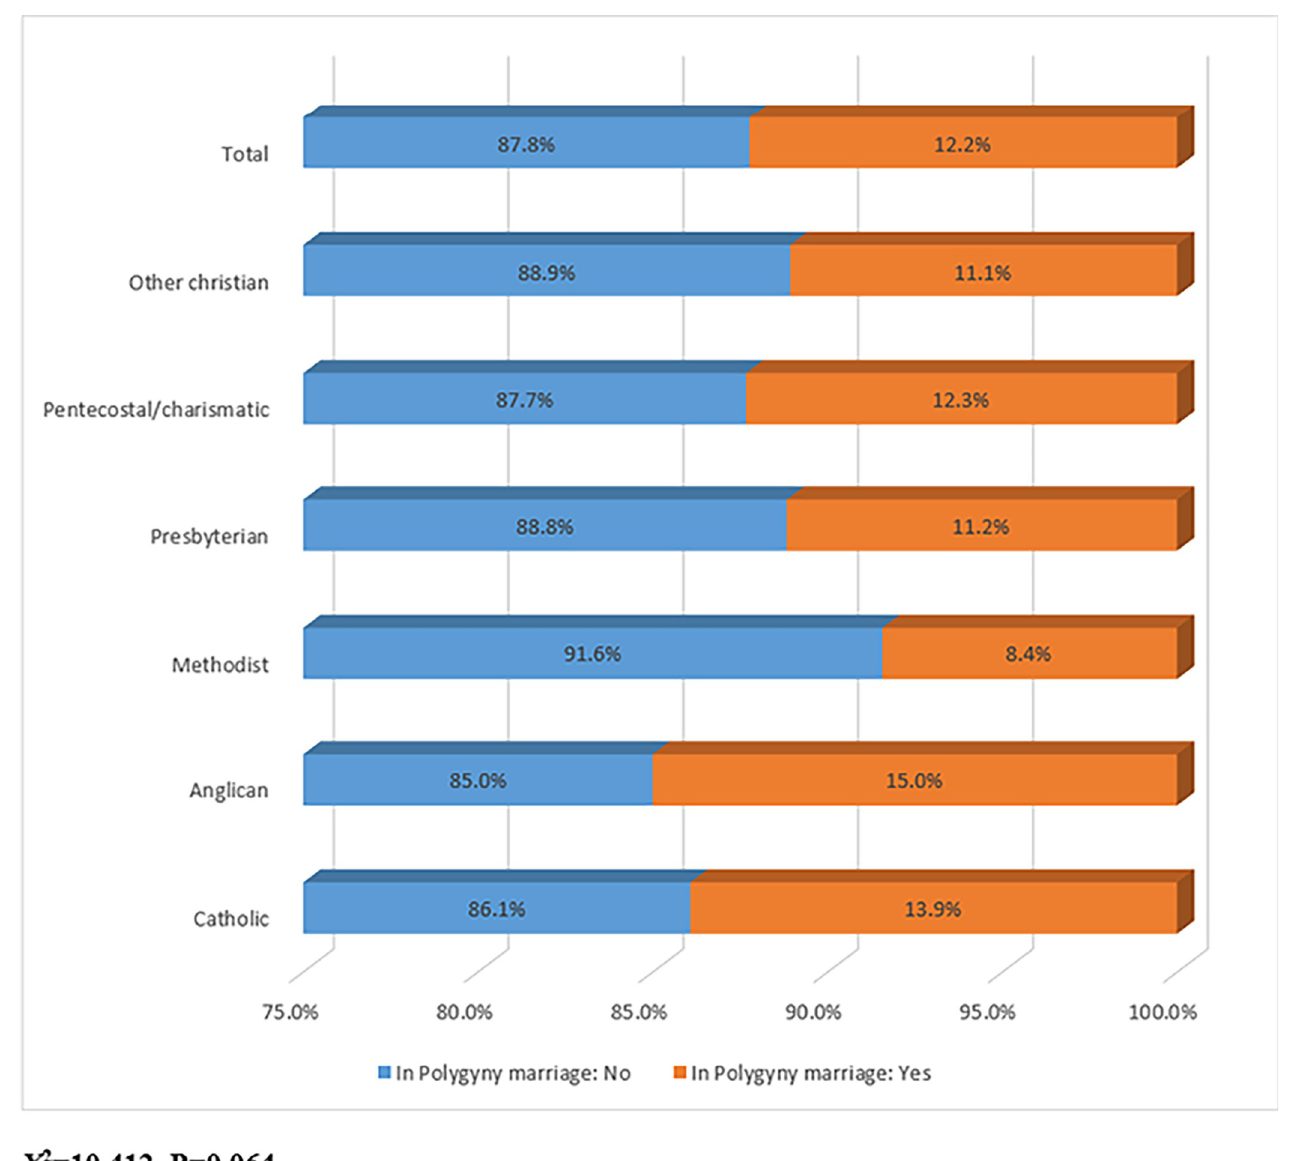
Fig 1. Prevalence of Christian women involved in a polygyny